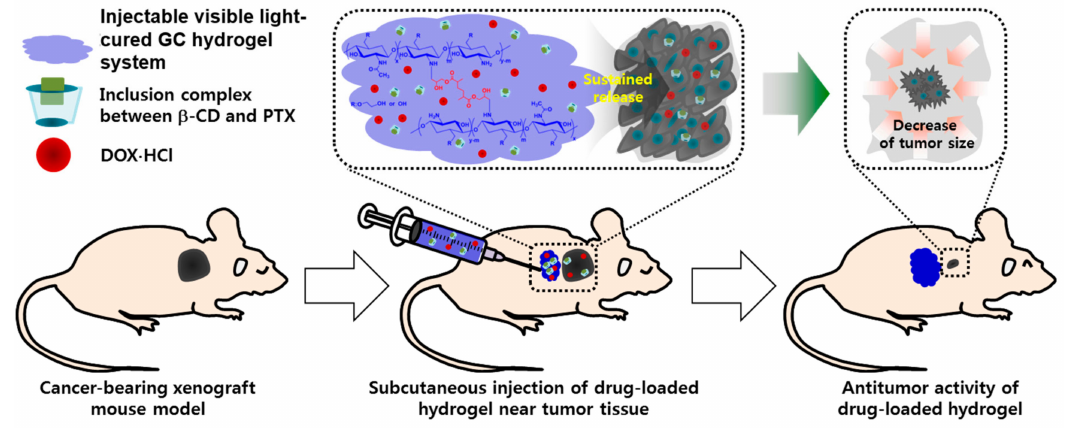
Figure 8. Expected mechanism of GDCP on the anticancer e ff ect of breast cancer in